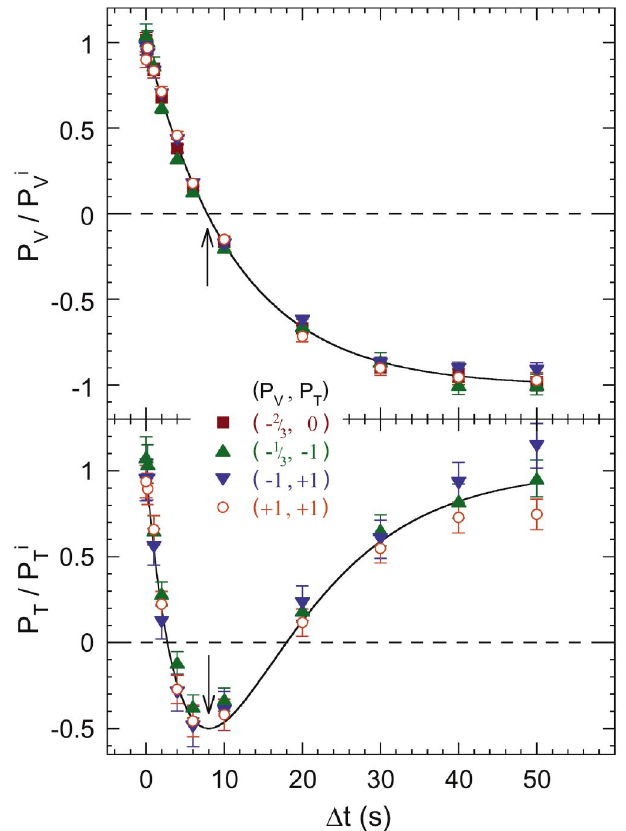
FIG. 5. (Color) The measured vector and tensor deuteron polarization ratios at 1850 MeV =c are plotted against the rf and P i were obtained from fits dipole ramp time (cid:18) t . The P i V T to the data as shown in Table II. The rf dipole’s frequency half- dl was 0 : 54 T mm . The range (cid:18) f= 2 was 100 Hz , and its R B rms top and bottom curves are fits to all states’ data using Eqs. (9) and (11), respectively. The arrows mark a 90 (cid:11) rotation where (cid:2) 0 and P (cid:2) (cid:4) 1 P i P V T T 2 # l and (cid:23) than Eqs. (10) and (12)